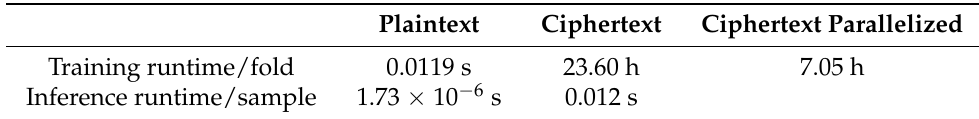
Table 2. Training and inference runtime comparison between plaintext and ciphertext implementation versions for the seizure detection use case.